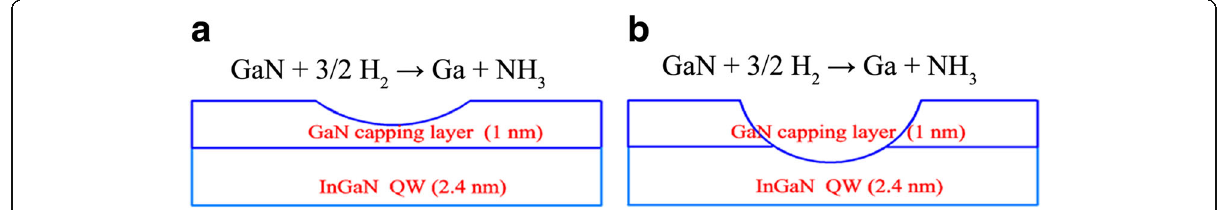
Fig. 5 a The etch effect on LT-GaN cap layer with H 2 percentage lower than 10%. b the H 2 over etch effect on LT-GaN capping layer under large H 2